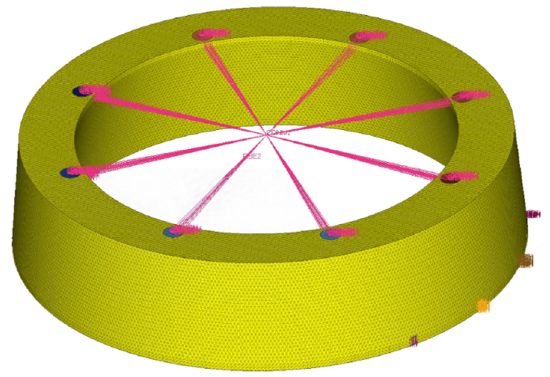
Figure 5. Analysis model in topology optimization; the yellow solid domain is the design domain, and the blue round hole domains are the non-design domains.